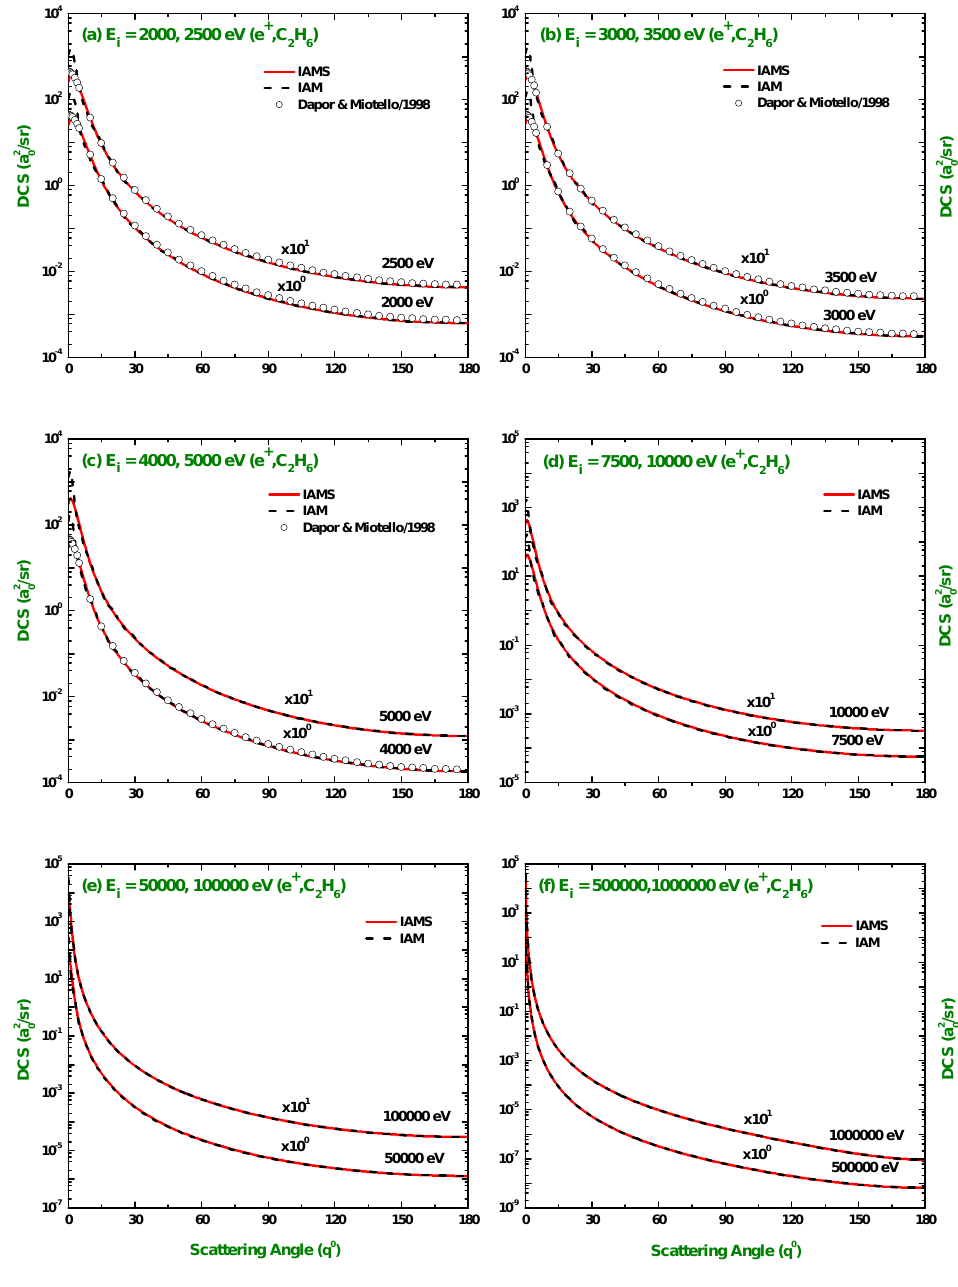
Figure 7. DCS ( a 2 / sr ) for the elastic scattering of positrons from C 2 H 6 at energies of 2.0 keV to 1 MeV. 0 Theoretical works: References in Figure